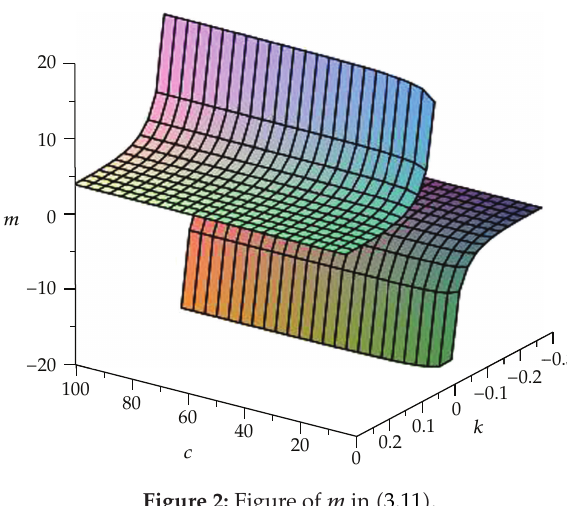
Figure 2: Figure of m in (cid:3) 3.11 (cid:4)